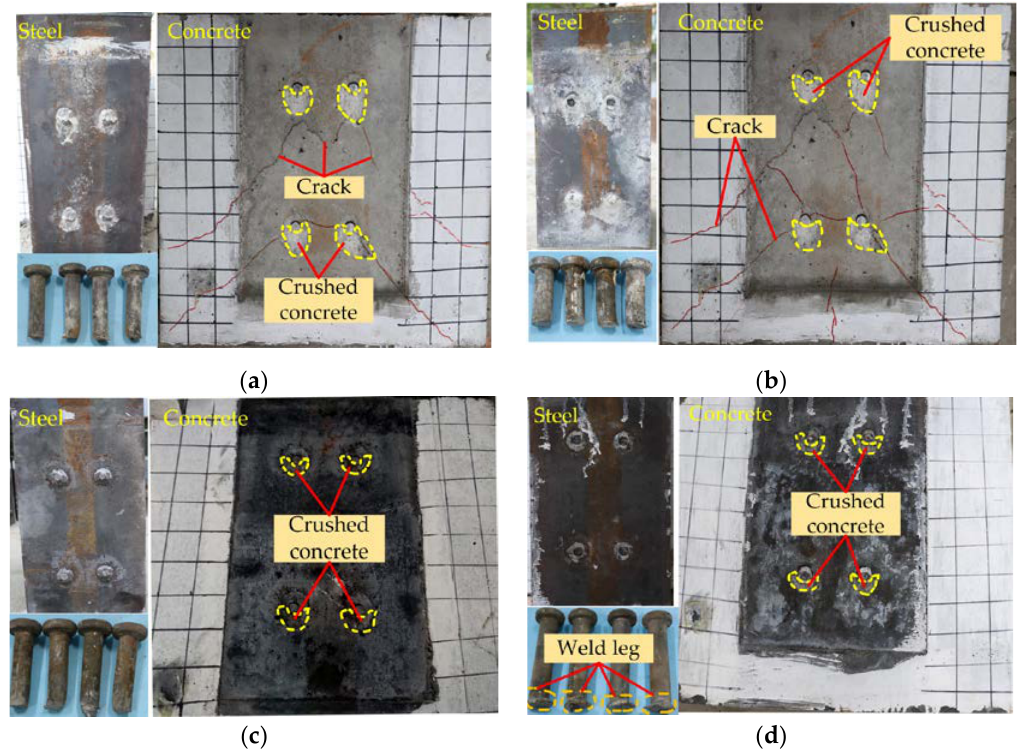
Figure 3. Failure modes of test specimens: ( a ) N80-16; ( b ) N80-22; ( c ) H80-16; ( d )